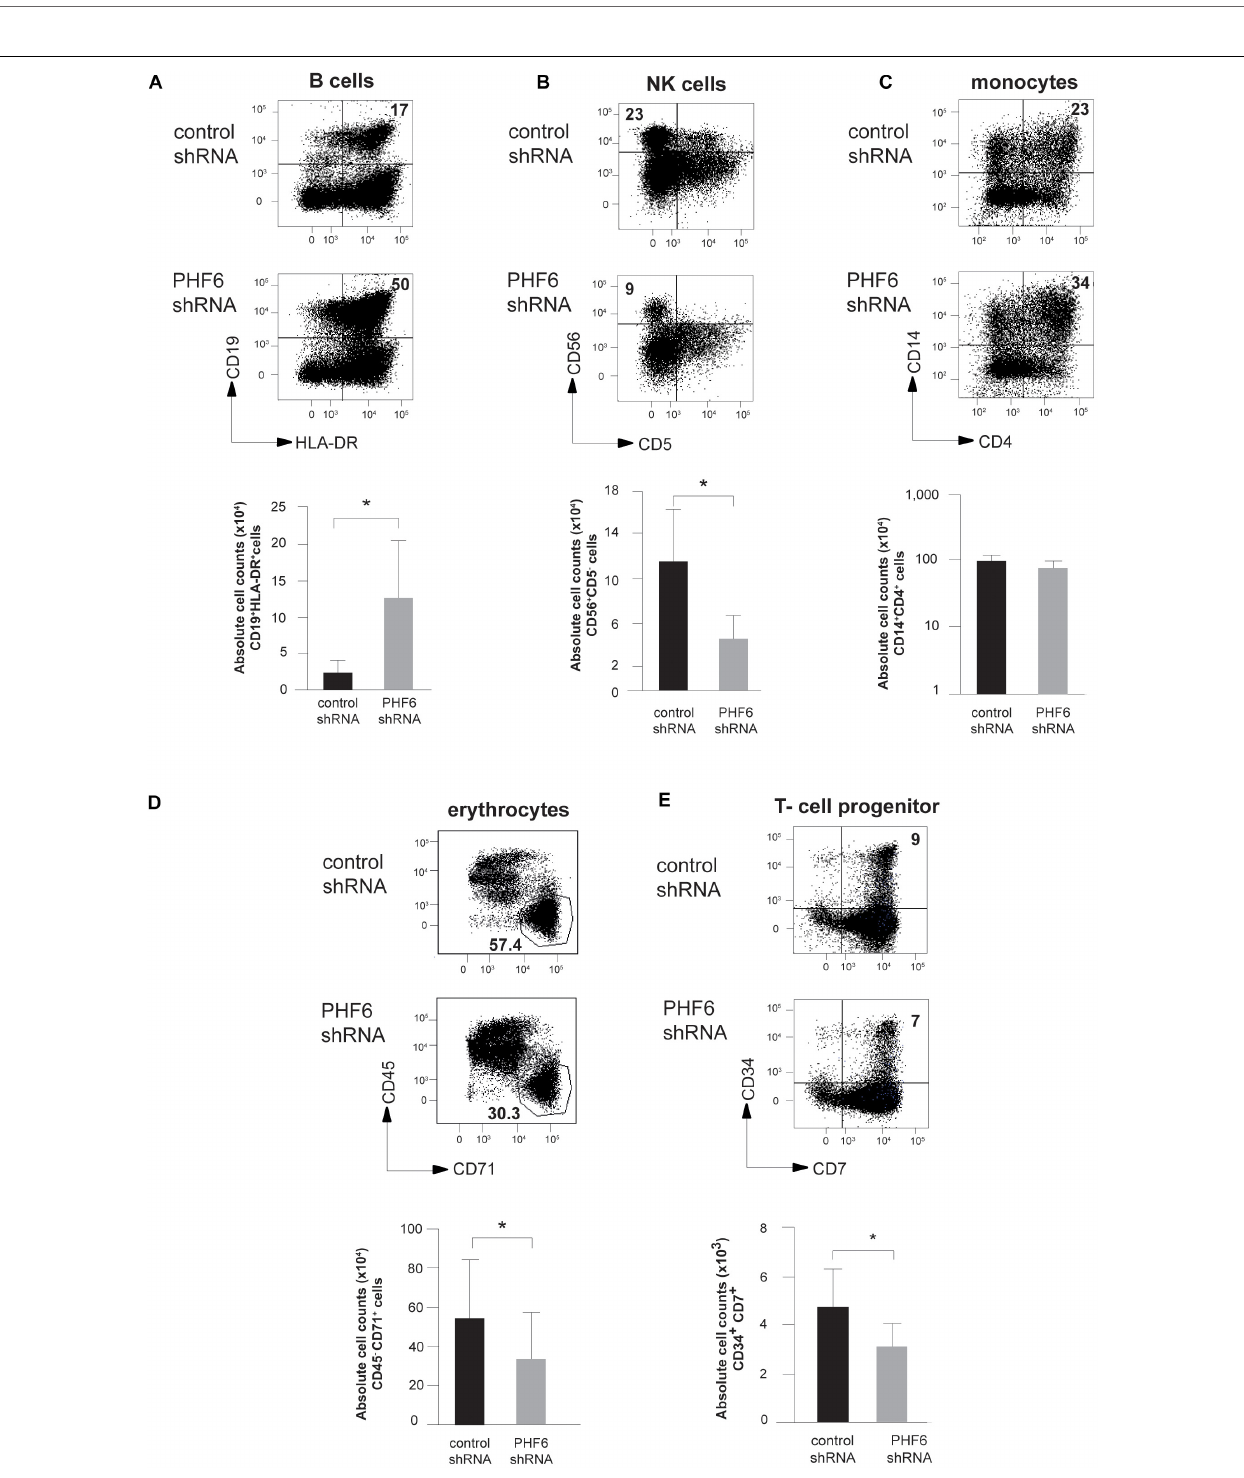
FIGURE 2 | PHF6 is essential for normal hematopoietic differentiation. (A–D) ( up ) Dot plots show flow cytometry analysis of control and PHF6 shRNA transduced cord blood CD34 + Lin − precursors in OP9-GFP cocultures, showing the development of (A) CD19 + HLA-DR + B-lineage cells after 28 days of coculture, (B) CD56 + CD5- NK cells after 21 days of coculture, (C) CD14 + CD4 + monocytes after 14 days of coculture and (D) CD45 + CD71 − erythrocytes after 7 days of coculture. Bar plots ( down ) show absolute numbers of corresponding populations. (E) ( up ) Dot plots show flow cytometry analysis of control and PHF6 shRNA transduced cord blood CD34 + Lin − precursors in OP9-DLL1 cocultures, showing the development of CD34 + CD7 + T cell precursors after 7 days of coculture. Bar plot ( down ) shows absolute numbers of the corresponding population. Data shows average of 5–7 independent experiments and error bars indicate SEM. * P < 0.05 (non-parametric paired Wilcoxon